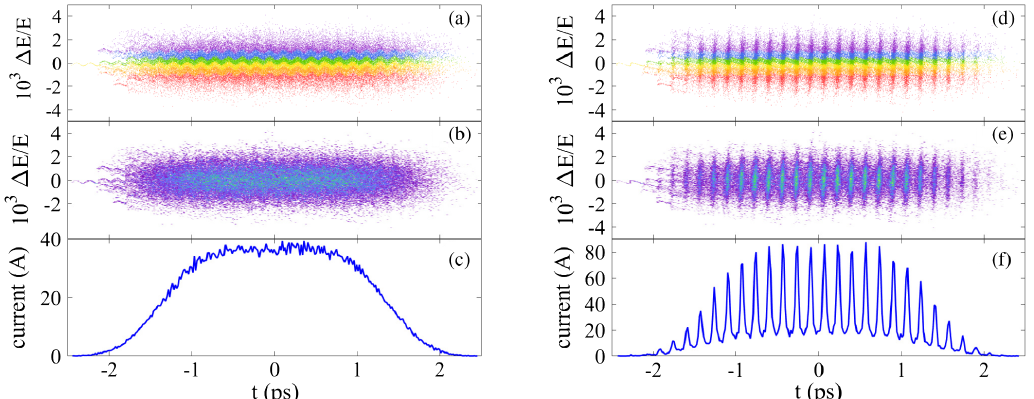
FIG. 3. Longitudinal phase space distribution of the electron beam at the exit of energy modulator (a – c) and dispersion section (d – f). In (a) and (d), the electrons are grouped into 6 “ layers ” according to their angular divergence x 0 at the entrance of energy modulator, and electrons in each layer are represented in a different color. (b) and (d) are pseudocolor plots of electron density distribution, while (c) and (f) are current